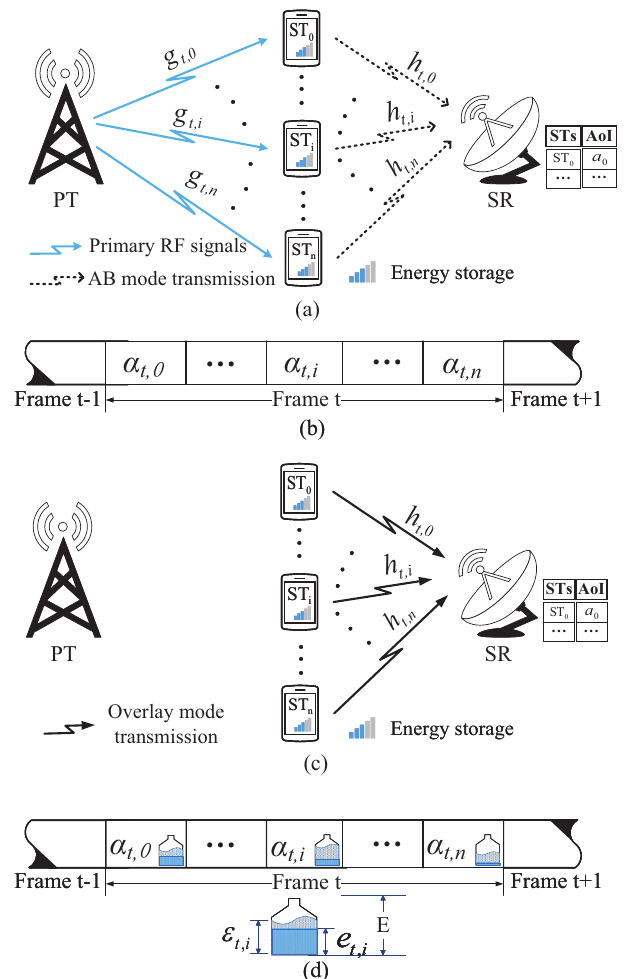
Figure 1. System model and frame structure of the AB-assisted overlay CRN: ( a ) depicts the system = 1, i.e., the channel is active. ( b ) depicts the time frame structure when s a model when s a t = 0, i.e., the channel is inactive. ( d ) depicts the time frame ( c ) depicts the system model when s a t = 0. structure when s a t